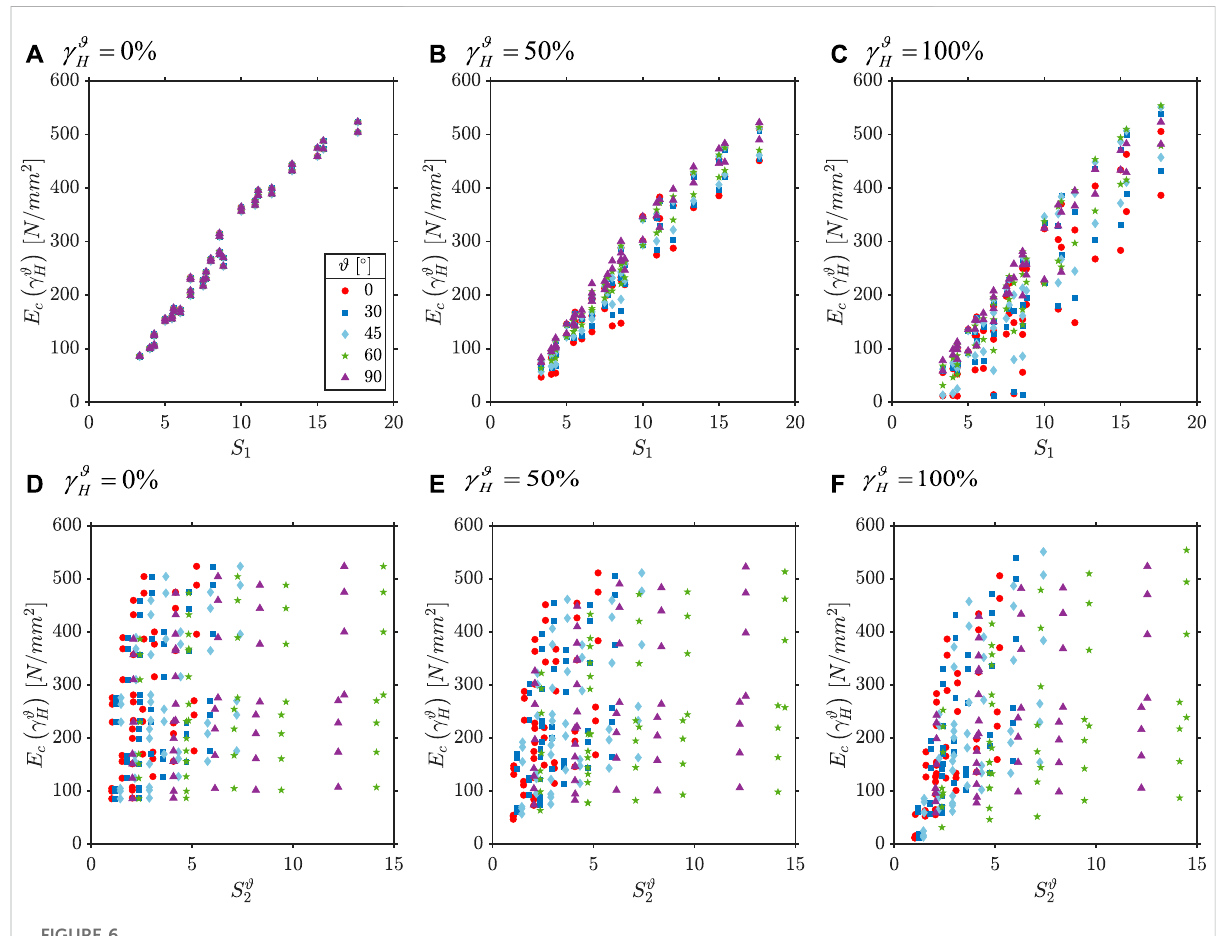
FIGURE 6 Trends of the effective compressive modulus with the primary and secondary shape